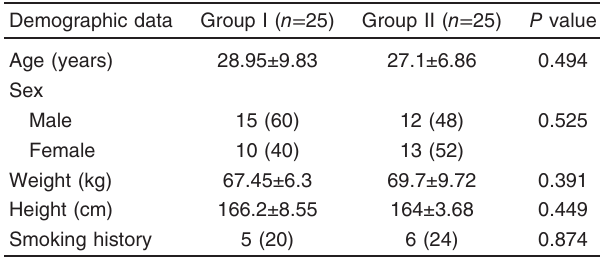
Table 1 Demographic data in group I versus group